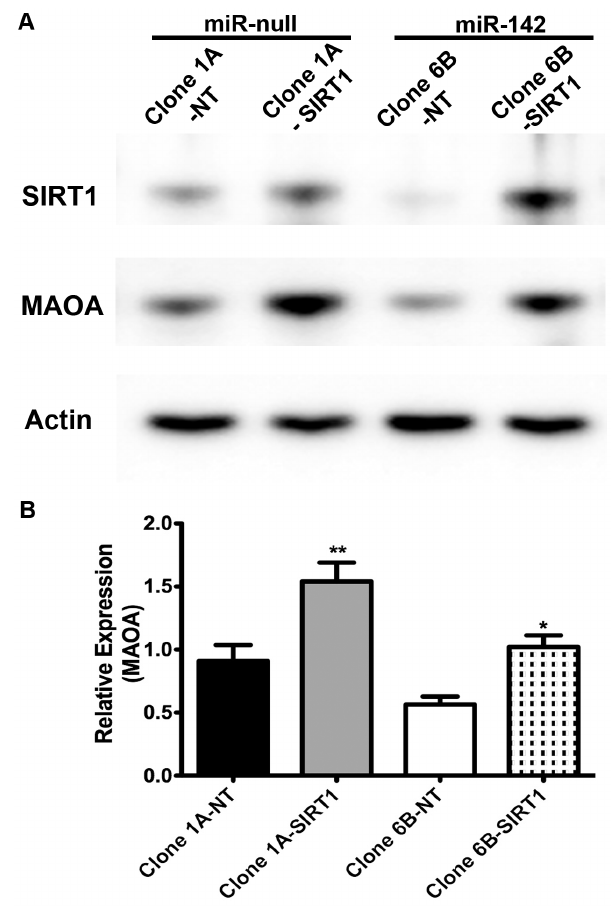
Figure 3. Overexpression of SIRT1 in BE(2)M17 clones leads to increase in MAOA protein levels. (A) Representative Western blot for SIRT1 and MAOA in BE(2)M17 clones 1A (miR-null) and 6B (miR-142). As predicted, clone 6B has lower levels of SIRT1 compared to clone 1A. Transfection of SIRT1 results in overexpression of the same, as well as increase in MAOA protein levels in both the clones. (B) Quantification of MAOA expression by Western blot analysis after three independent transfection experiments. MAOA protein level was increased by 1.7-fold in clone 1A and 1.8-fold in clone 6B after transfection of SIRT1. Blots were normalized to b -actin and one-way ANOVA was performed followed by Bonferroni’s multiple correction test. ** represent p , 0.01, * represents p , 0.05, error bars are standard error of mean, NT= non-transfected.